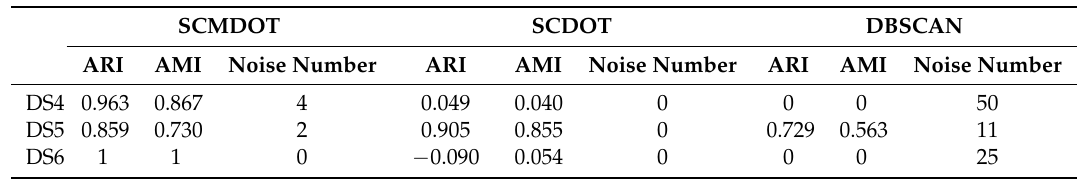
Table 3. Results in Adjust Rand index (ARI) and Adjusted Mutual Information (AMI) for DS4, DS5, and DS6 datasets.